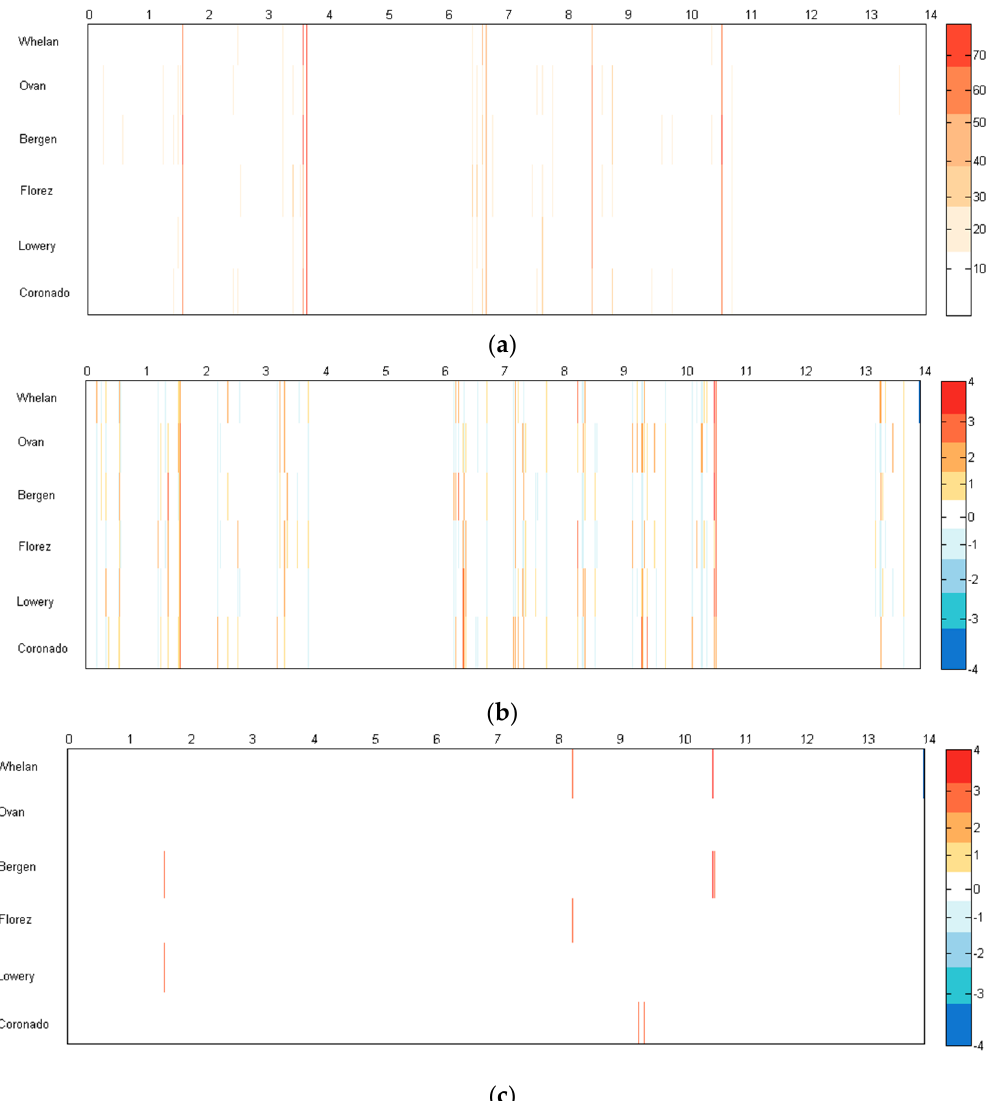
Figure 7. The anomaly heat maps, displaying ( a ) distances between attribute values and corresponding values of the cluster centroid; ( b ) z-score of the distances; ( c ) z-score of the distances having values in the ranges [ − 4, − 2.58) and (2.58,